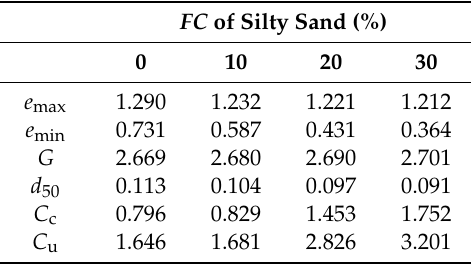
Table 2. Physical index of Nantong marine silty sand with different FC.